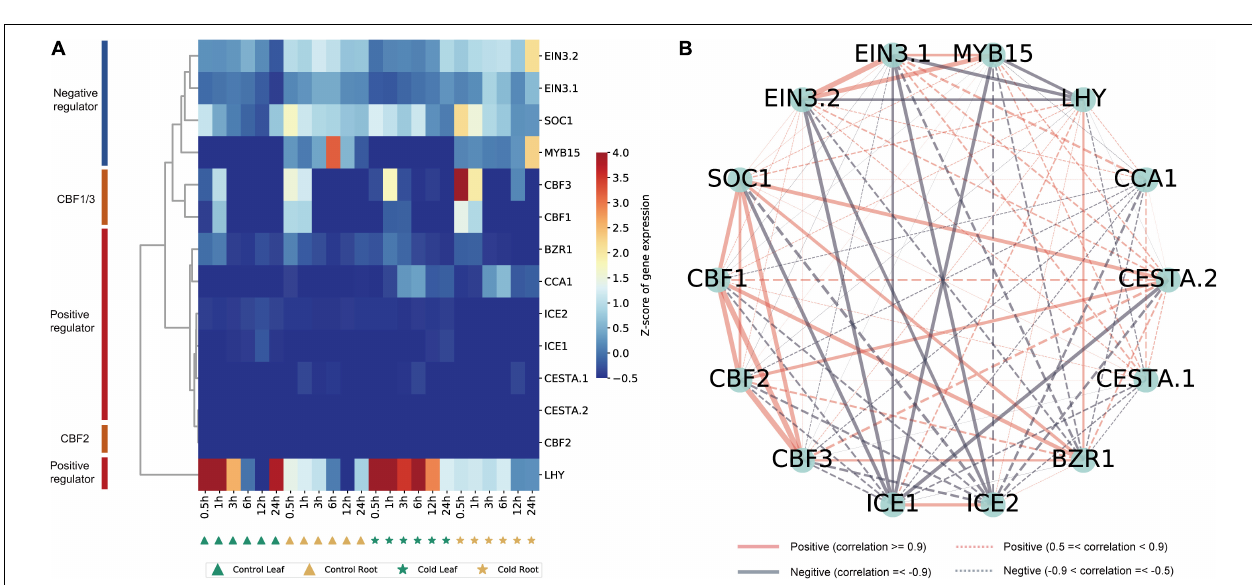
FIGURE 6 | Kyoto encyclopedia of genes and genomes (KEGG) pathway enrichment analysis results for the DEGs in leaf (A) and root (B) among the six different time points. The complete list of DEGs and KEGG pathways for enrichment analysis is shown in Supplementary Tables 12 , 13 .